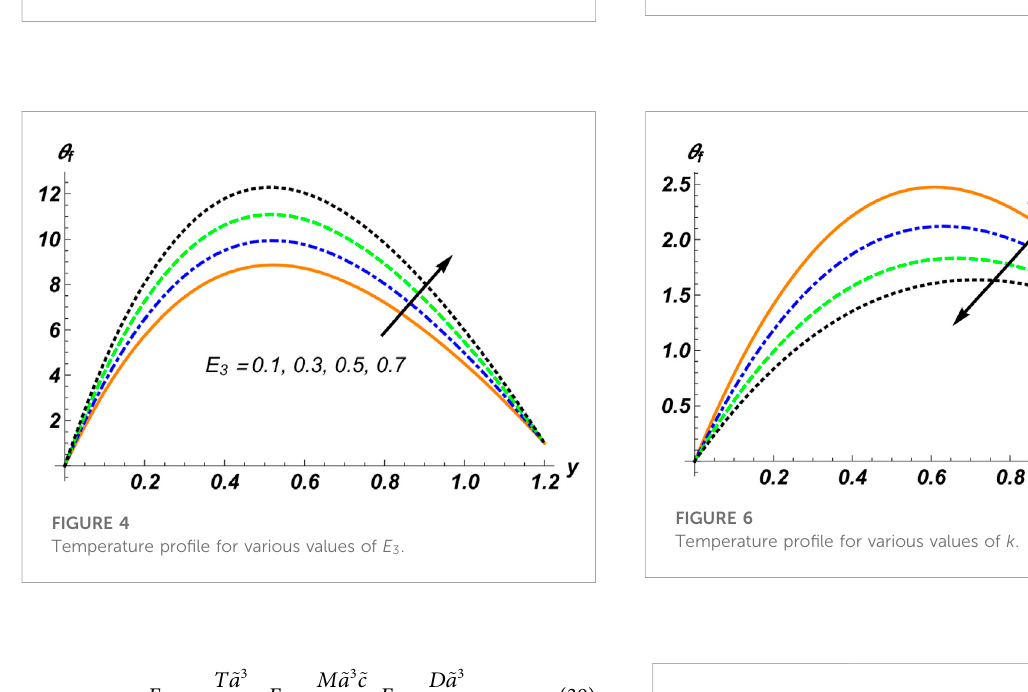
Temperature pro fi le for various values of E 2 .